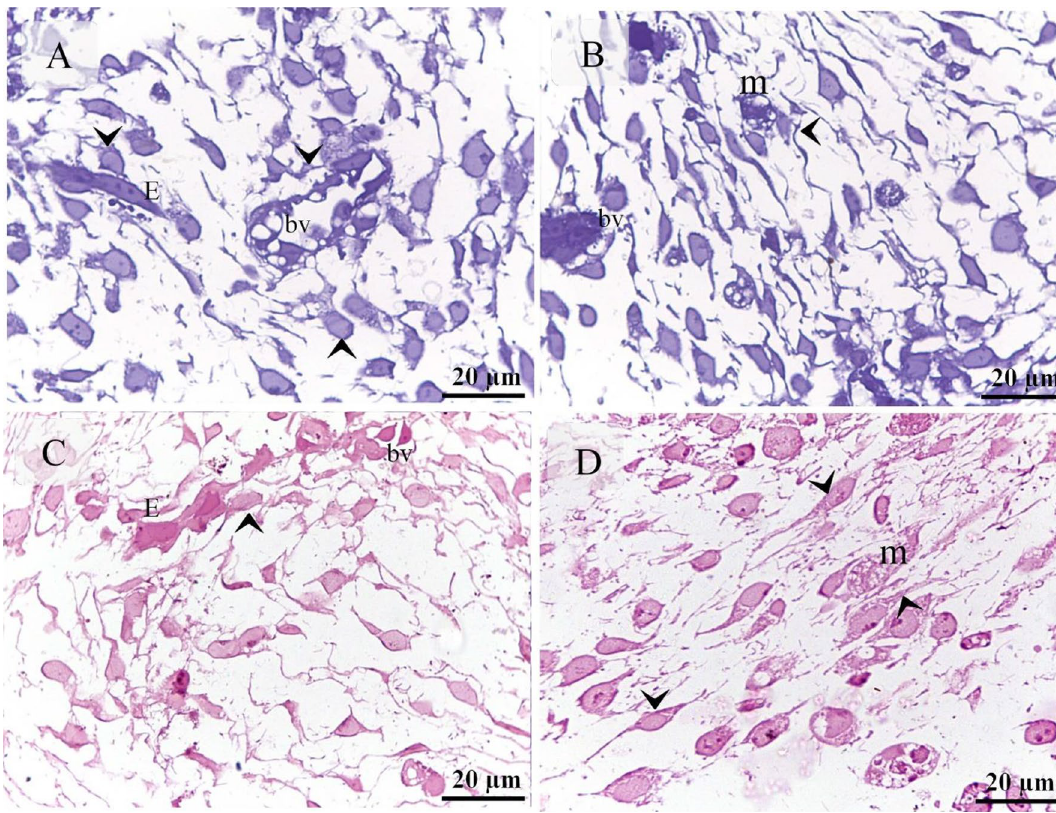
Figure 2. Recognition of perivascular TCs using semithin sections. Semithin sections of the neck skin of day 5 quail embryos stained by toluidine blue ( A , B ) and PAS ( C , D ). ( A , C ) TCs (arrowheads) located around sprouting endothelial cells (E) and blood vessel (bv). ( B , D ) TCs (arrowheads) located around active macrophages (m), which exhibited vesicular cytoplasm. Note the blood vessel (bv).